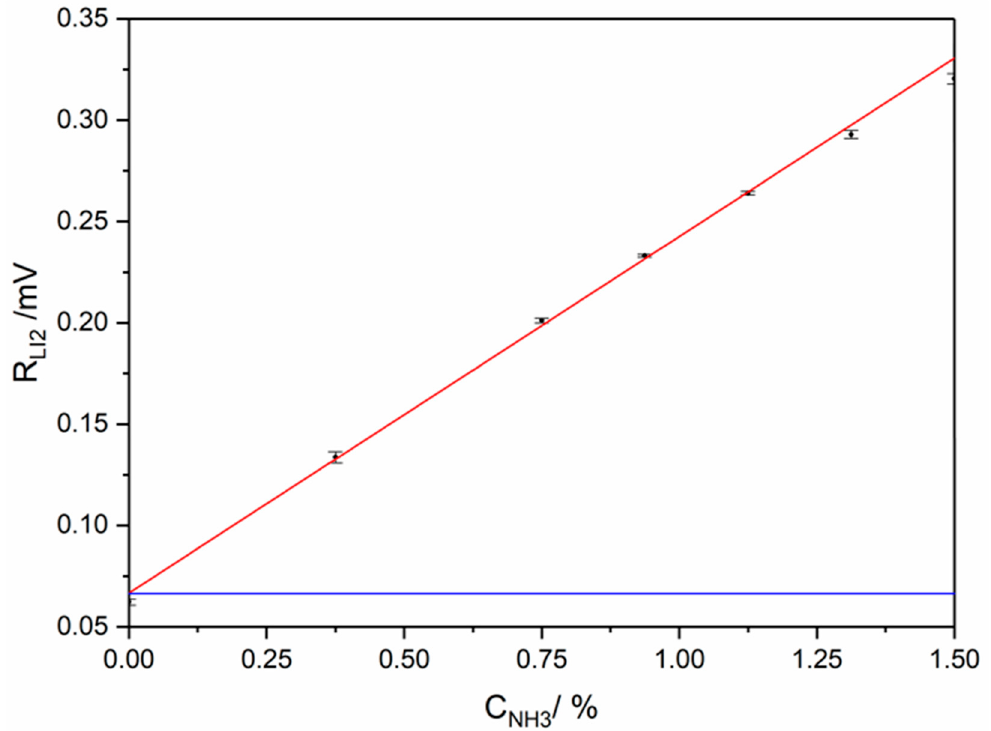
Figure 5. Determination of the limit of detection of NH 3 in synthetic air. The blue line marks the sum of the mean value of the noise floor and 3 times its standard deviation.